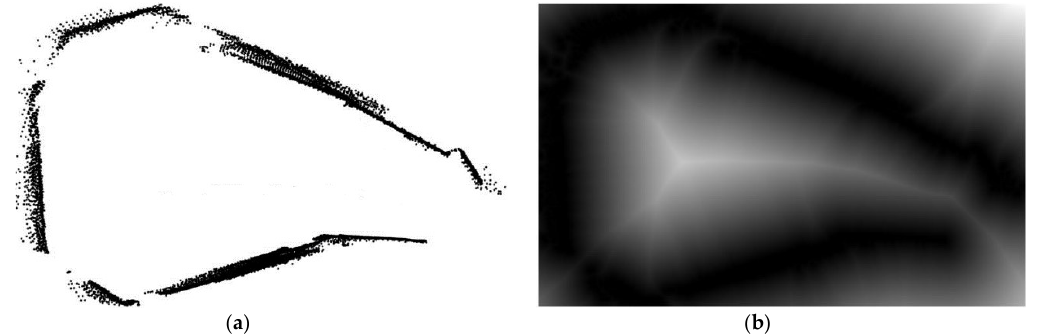
Figure 6. Part of the constructed map II: ( a ) binary representation; and ( b ) the corresponding result using the DT method.